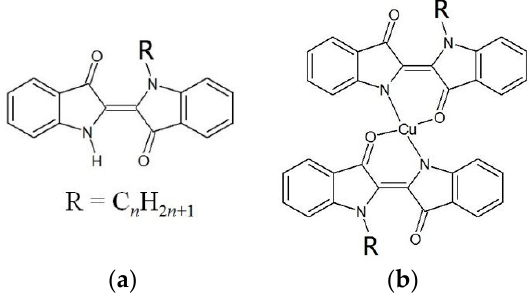
Figure 1. Chemical structures of ( a ) C n IND and ( b ) [Cu(C n IND) 2 ].